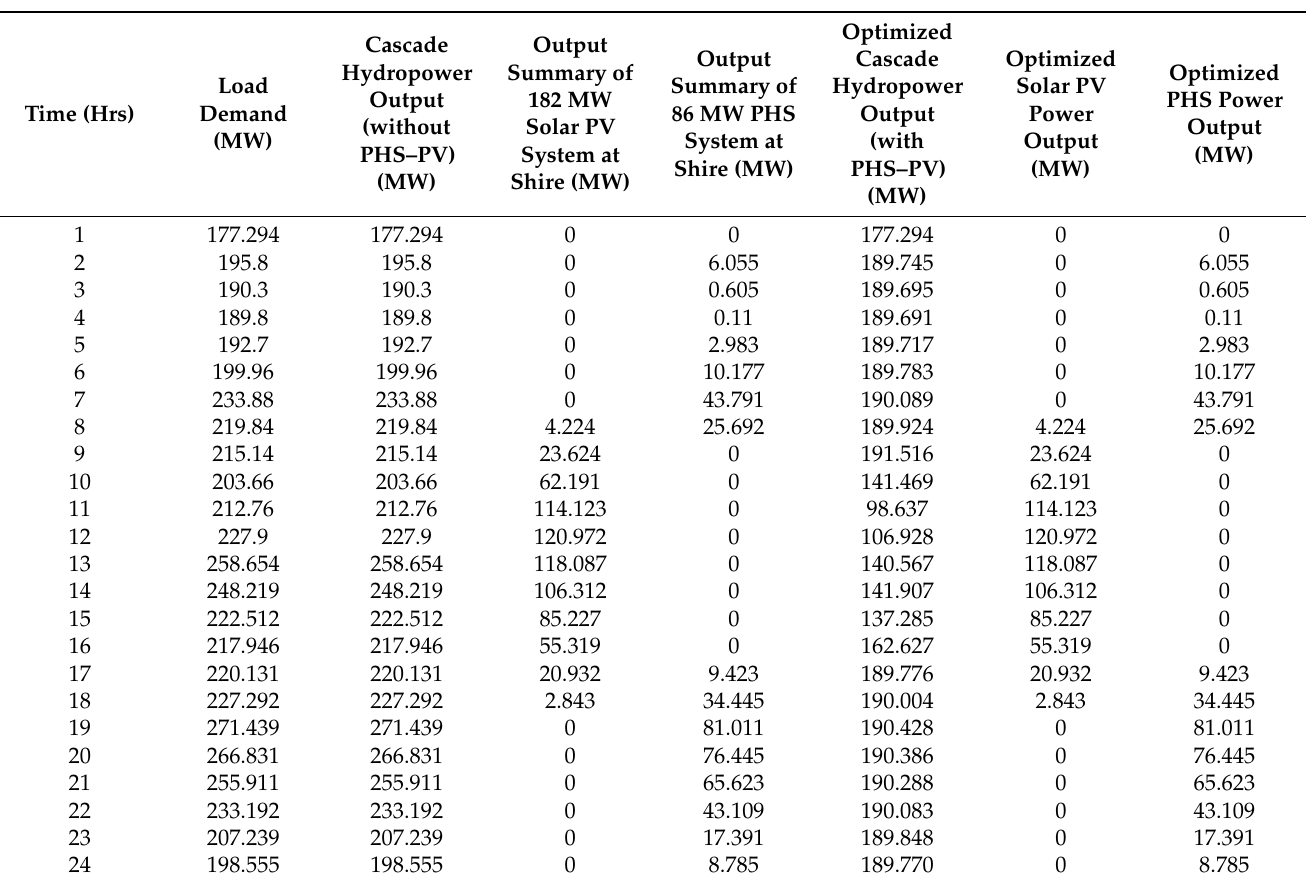
Table 3. Optimized electricity output